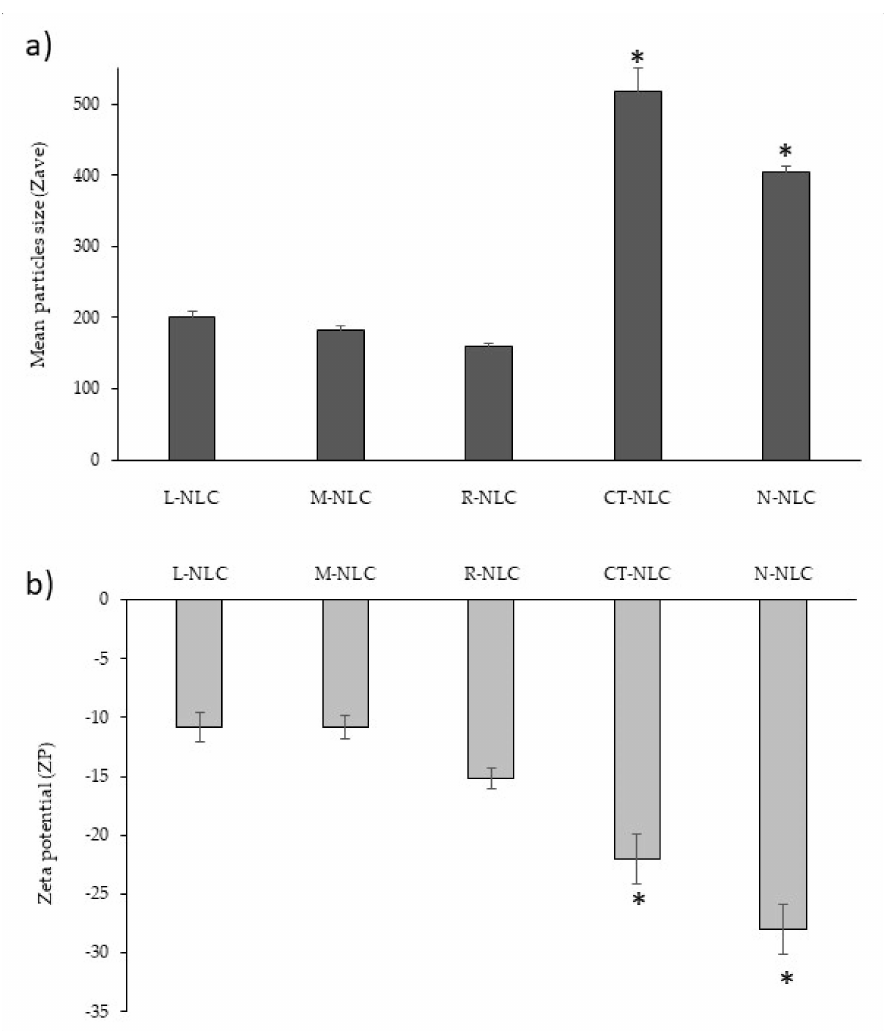
Figure 1. ( A ) Mean particle size (Zave, nm) and ( B ) Zeta Potential (ZP) ± standard deviation (SD) of the prepared Lavandula NLC (L-NLC), Mentha NLC (M-NLC), Rosmarinus NLC (R-NLC), Tegosoft CT NLC (CT-NLC) and Neem NLC (N-NLC). * Significance for p < 0.05, comparison between EO-loaded NLC (L-NLC, M-NLC, and R-NLC) and the control NLC (CT-NLC and